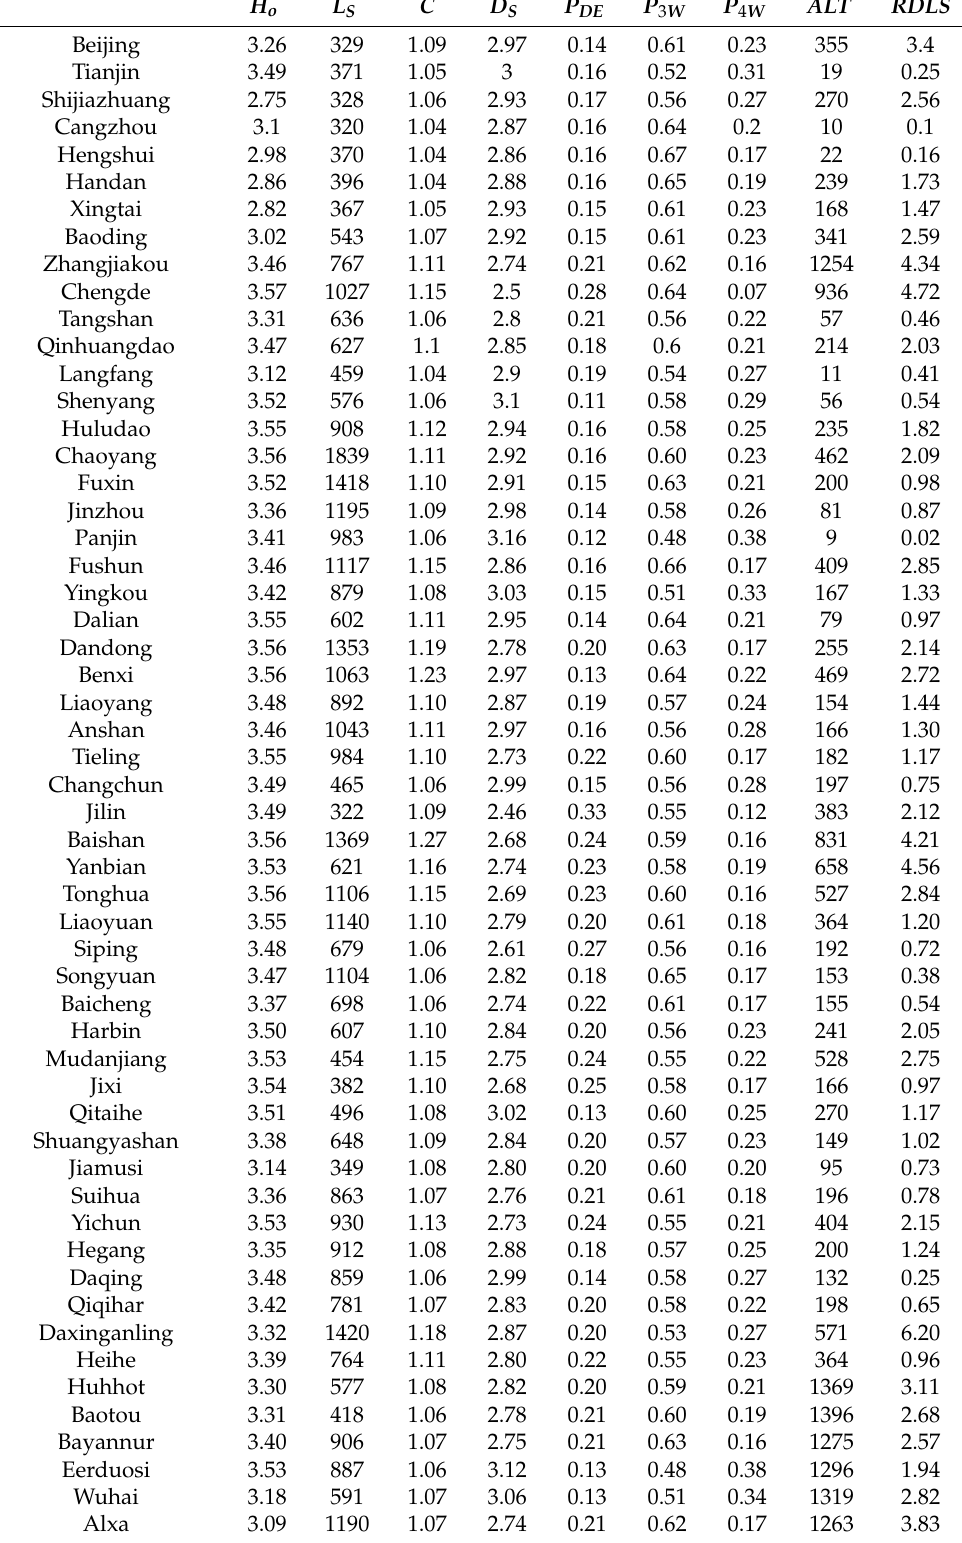
Table A1. Calculation results of each index for prefecture-level